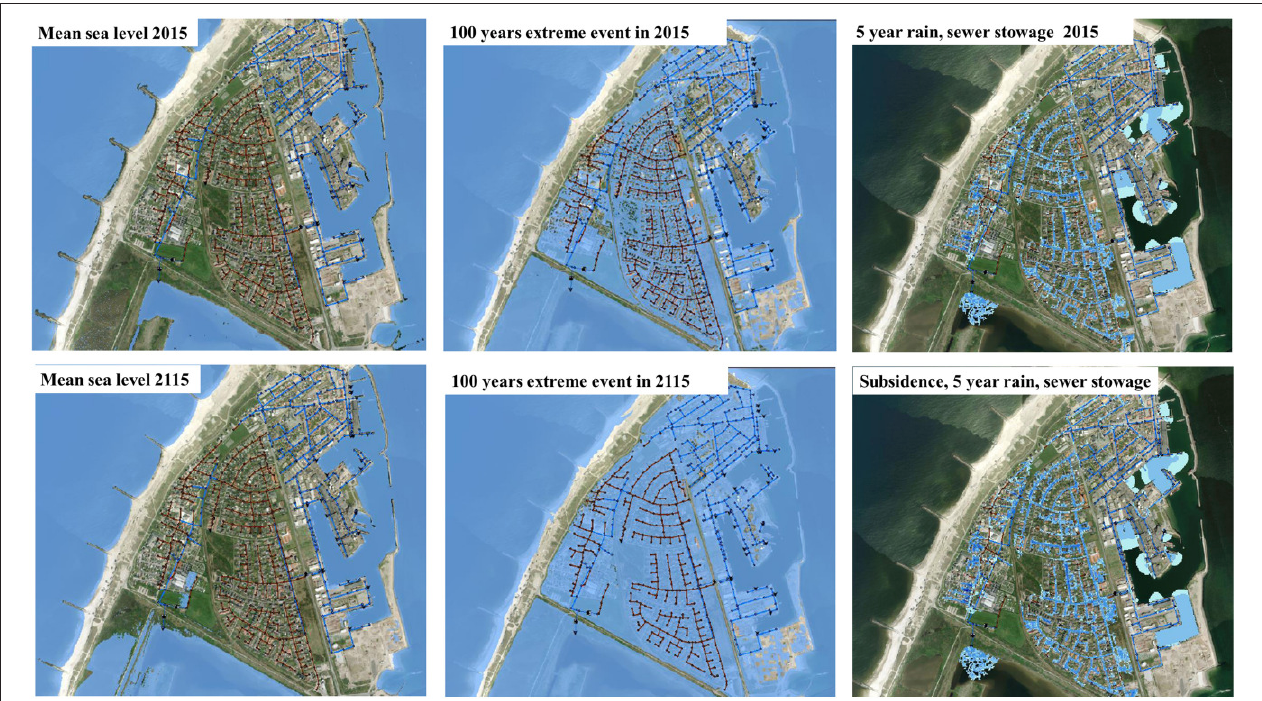
FIGURE 11 | Examples from the MIKE modeling. A rise in mean water level will in itself not have a significant impact on flooding in 2115 compared with today, even if the groundwater level is raised (left) . Today Thyboron is potentially at risk of getting flooded from a 100 year event. A similar event in 2115 including sea level rise and land subsidence will “drown” the town (a similar scenario potentially can occur in 2065) (middle) . The sewer system will experience increased stow up from precipitation with a raised groundwater level, or, due to subsidence (right)